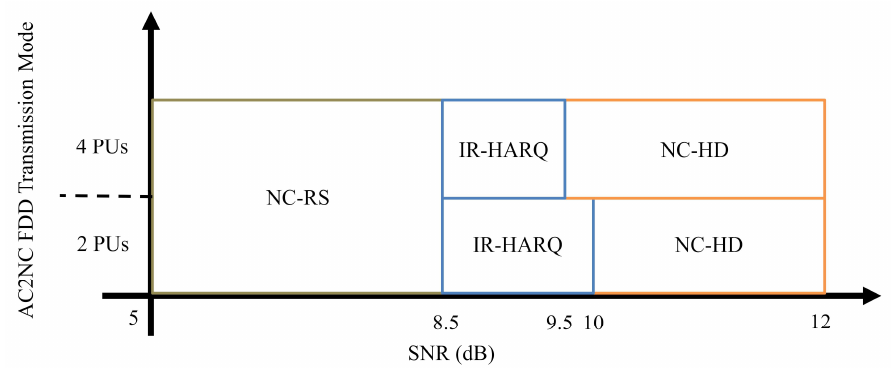
Figure 5. AC2NC relative time saving.